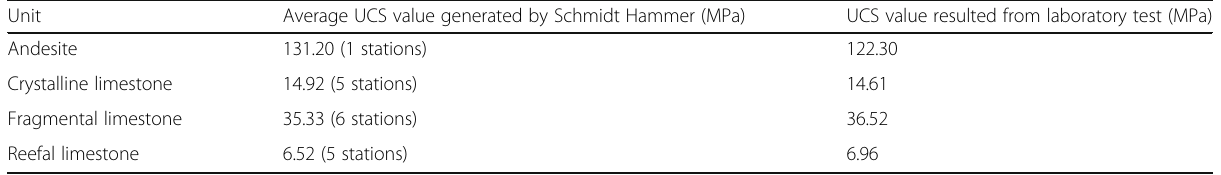
Table 12 Comparison of UCS values resulted from Schmidt Hammer and laboratory test Unit Average UCS value generated by Schmidt Hammer (MPa)